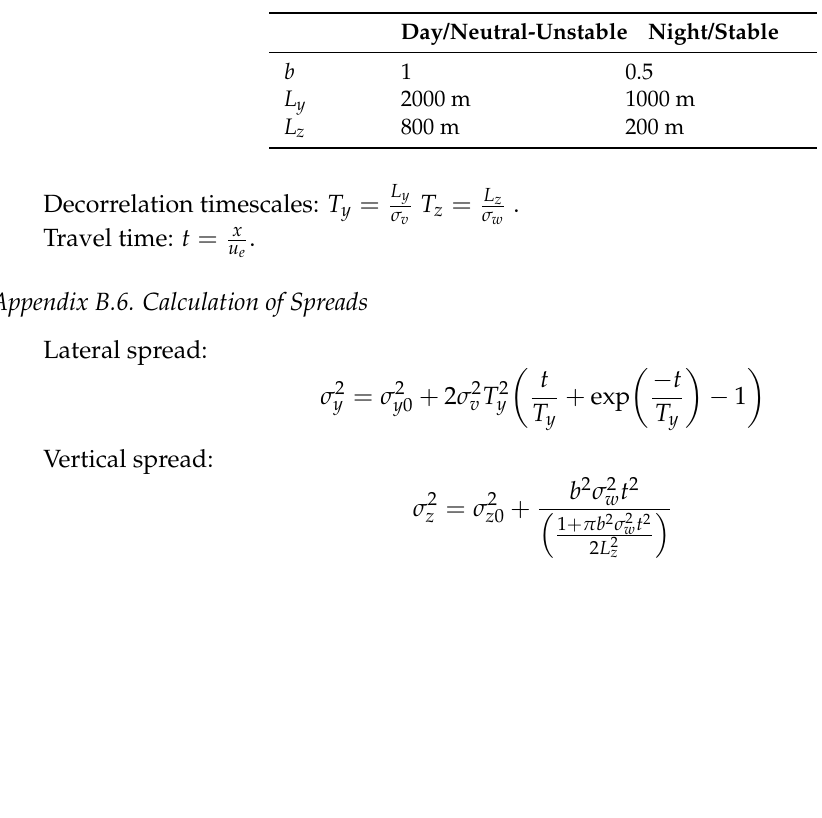
Table A3. Values required by reference model for constant b and length scales for neutral/unstable, and stable